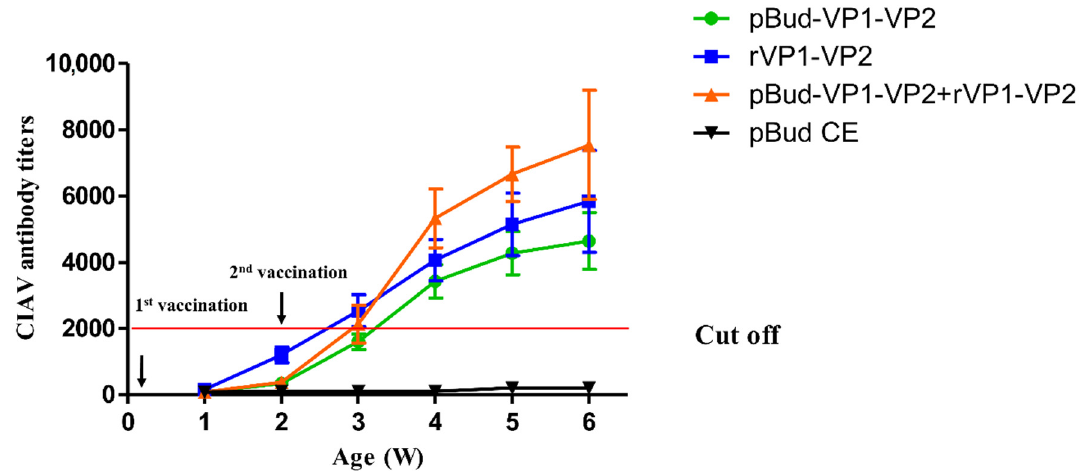
Figure 3. Identification of pBud-VP1-VP2 expression by IFA. ( A ): IFA detection with mouse anti-VP1 antibody. ( B ): IFA detection with rabbit anti-VP2 antibody. ( C ): Staining with DAPI. ( D ): Merge of A, B, and C.